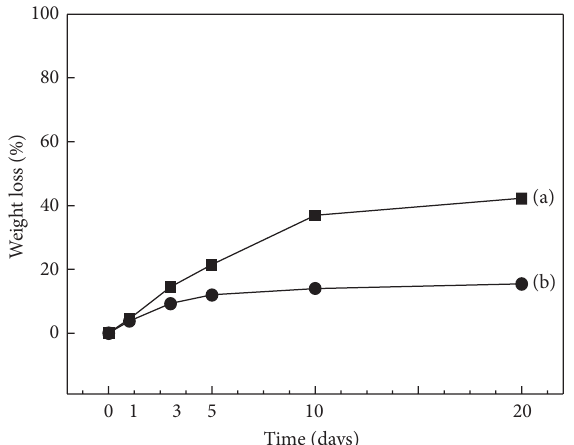
Figure 18: Weight loss (%) of (a) kenaf/SPI-PVA composite without GA and (b) kenaf/SPI-PVA composite having 8wt% of GA with compost time.